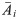
Gaze-weighted linear accumulator model.In the GLAM, preference formation during the decision process is dependent on the allocation of visual gaze (A). For each item in the choice set, an average absolute decision signal A¯i is computed (dashed lines in A). The magnitude of this signal is determined by the momentary allocation of visual gaze: While an item is currently not looked at, its signal is discounted by parameter γ (γ ≤ 1; discounting is illustrated by gray arrows) (A). To determine a relative decision signal Ri for each item in the choice set, absolute evidence signals are transformed in two steps (B): First, the difference between each average absolute decision signal A¯i and the maximum of all others is determined. Second, the resulting differences are scaled through a logistic transform, as the GLAM assumes an adaptive representation of the relative decision signals that is especially sensitive to differences close to 0 (where the absolute signal for an item is very close to the maximum of all others). The resulting relative decision signals Ri can be used to predict choice and RT, by determining the speed of the accumulation process in a linear stochastic race (C). The stochastic race then provides first-passage time distributions pi, describing the likelihood of each item being chosen at each time point.